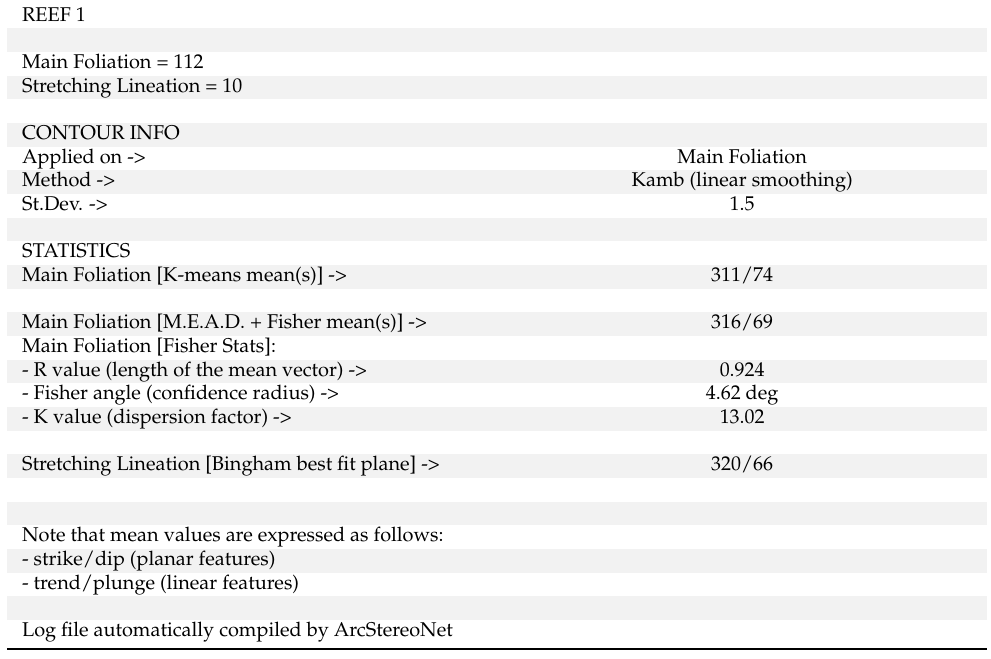
Table A3. ‘Reef 1 (cid:48) station log file. The original .txt file has been converted to table format. REEF 1 Main Foliation = 112 Stretching Lineation = 10 CONTOUR INFO Applied on -> Main Foliation Method -> Kamb (linear smoothing) St.Dev. ->